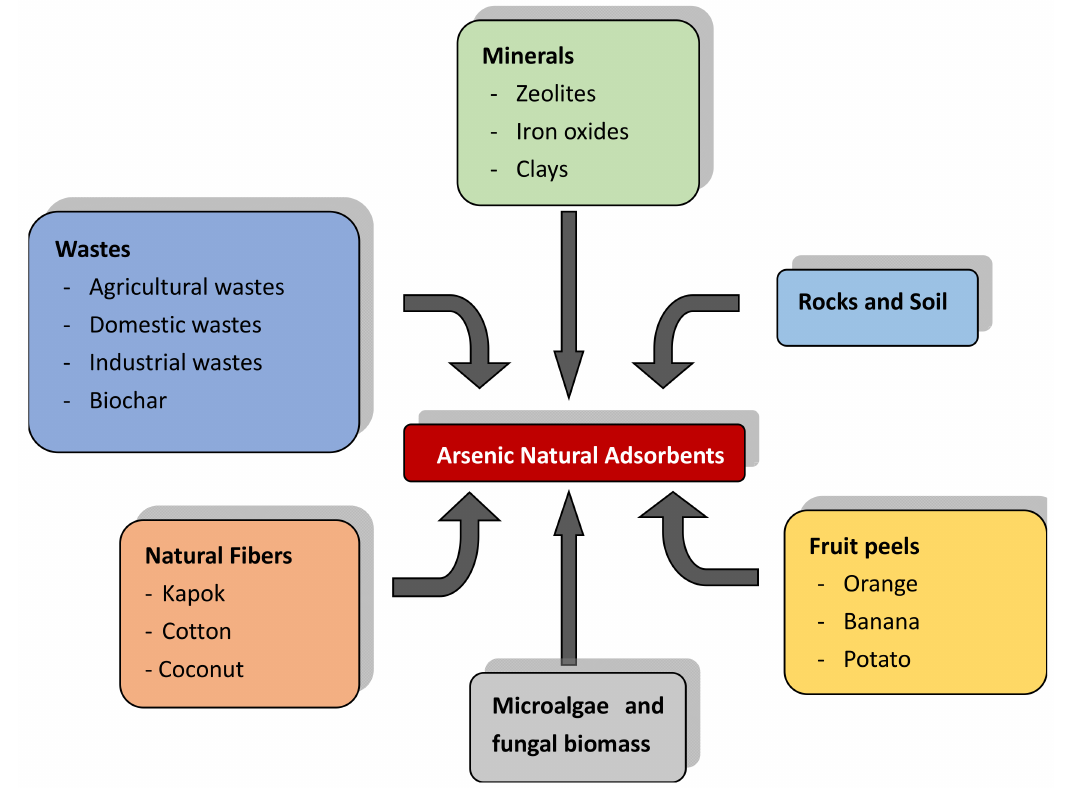
Figure 1. Different types of natural adsorbent As. Table 1. Some As natural adsorbents and their adsorption